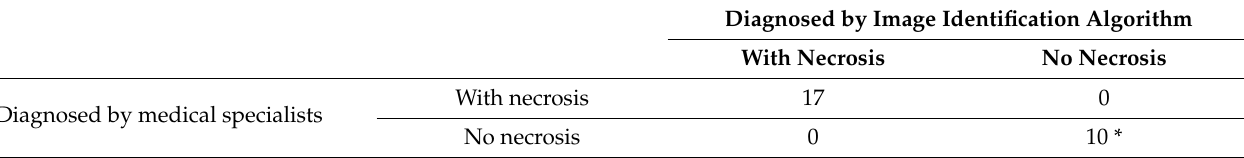
Table 3. The result of determination of necrosis ( n = 27) with medical specialists vs. image identifica- tion algorithm with the black-white pixel ratio.